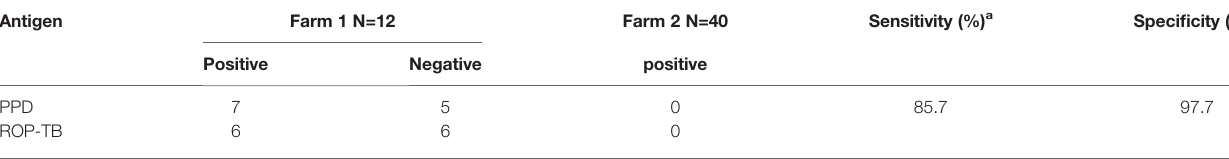
TABLE 1 | Delayed-type hypersensitivity skin test of ROP-TB and PPD cattle.